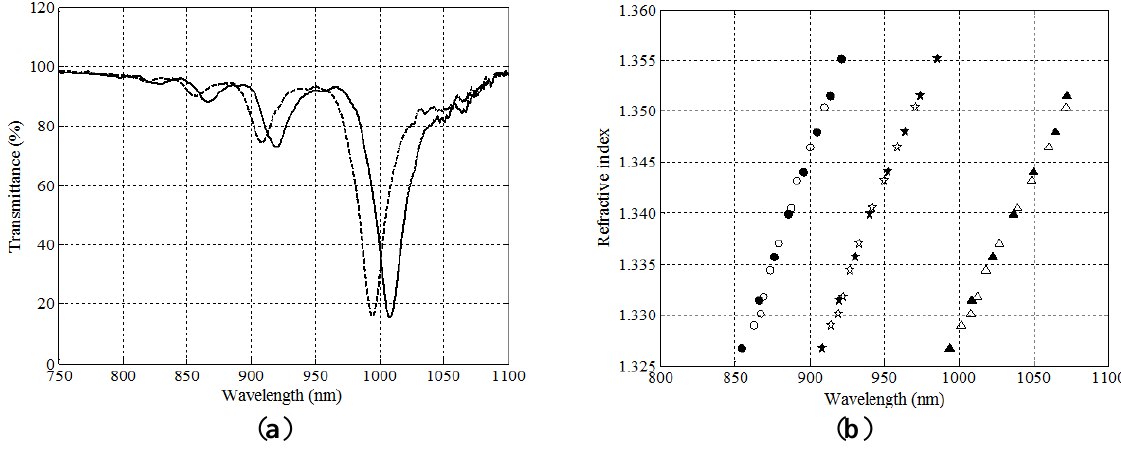
Figure 3. Representative experimental behavior of asymmetrically deposited DLUWTs. On the left ( a ), spectral transmittance, showing several plasmon dips, which displace themselves when changing outer refractive index; On the right ( b ) these displacement in terms of the value of plasmon